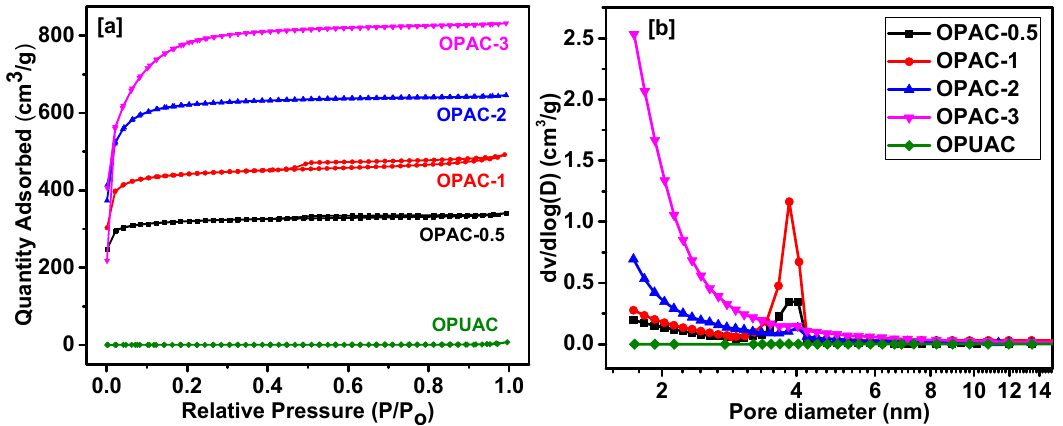
Figure 3. ( a ) Nitrogen adsorption–desorption isotherms and ( b ) BJH pore size distributions of OPUAC and OPAC carbons. Table 1. Pore characteristics and surface area of unactivated and activated carbons. a Surface area measured via BET method, b Total pore volume, and c Average pore diameter.